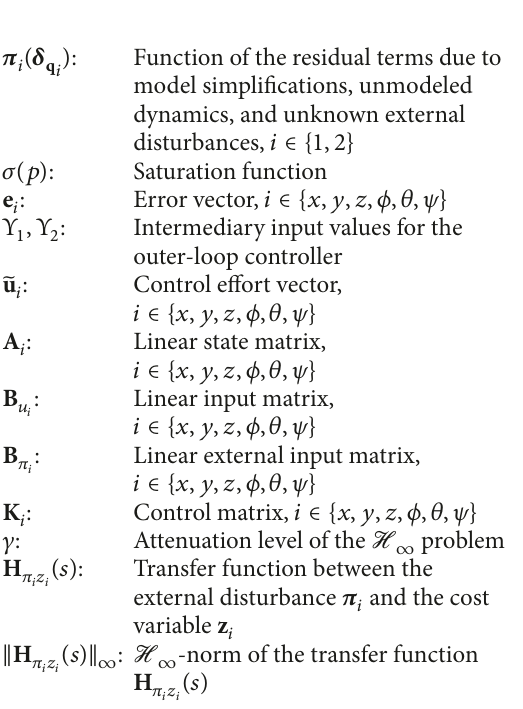
Figure 9: Inputs of the system using NLPT-2L, NLLS-2L, and